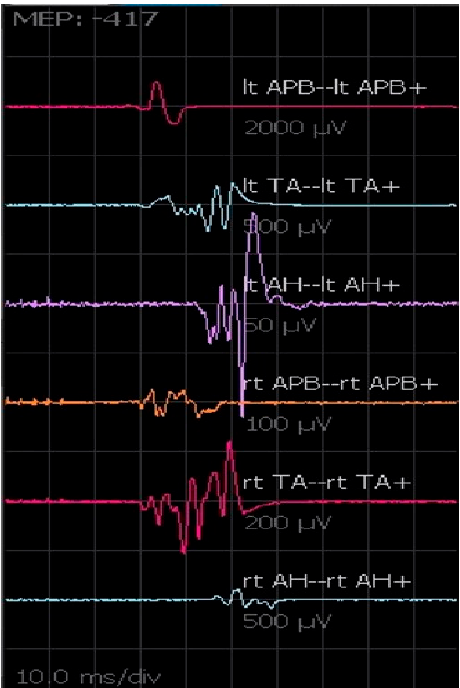
Figure 6. MEPs registered from the upper and lower limbs. The amplitude and morphology of the waves can change from one transcranial electrical stimulation to another.